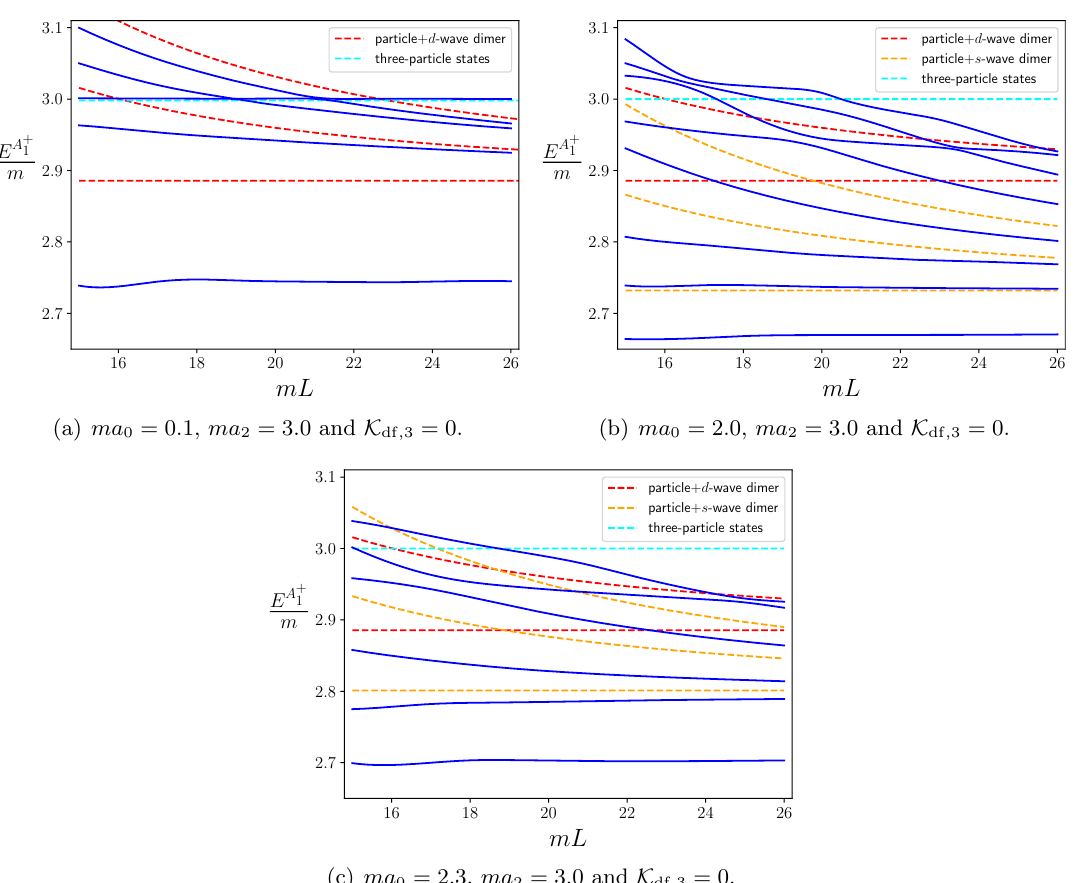
Figure 12 . Finite-volume spectra (solid blue lines) of the three-particle systems in the A + with both s - and d -wave two-particle interactions. Noninteracting three-particle levels, as well as those involving particle + dimer, are also shown. (In the upper right panel, the cyan dashed line at E = 3 m has been shifted slightly downward to make it visible.) See text for further